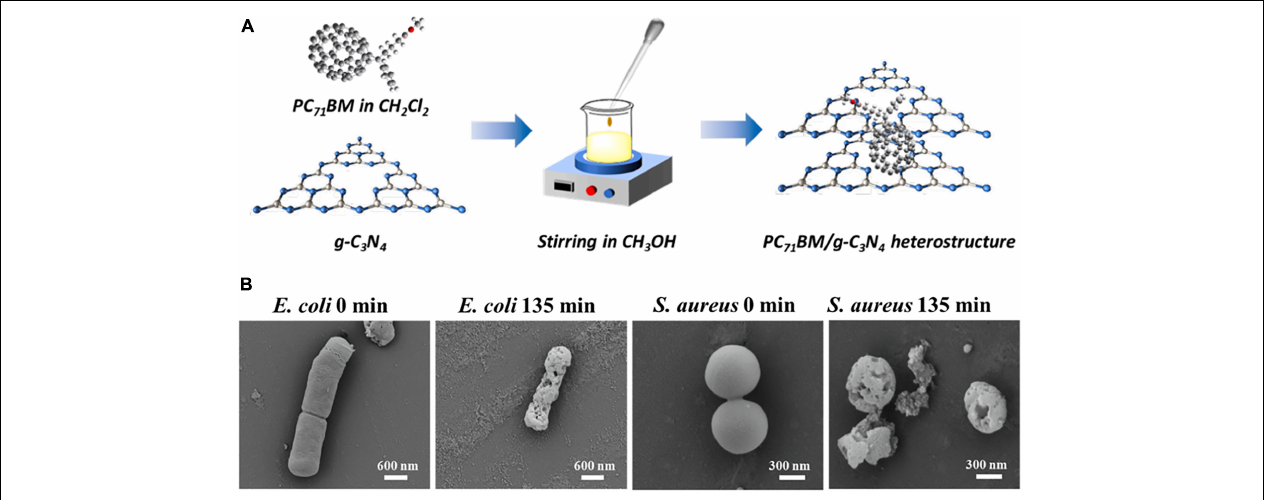
FIGURE 7 | (A) Schematic diagram of the fabrication of PC 71 BM/g-C 3 N 4 photocatalysts. (B) SEM images of E. coli and S. aureus before and after irradiation for 135 min with PC 71 BM/g-C 3 N 4 (Liu et al.,